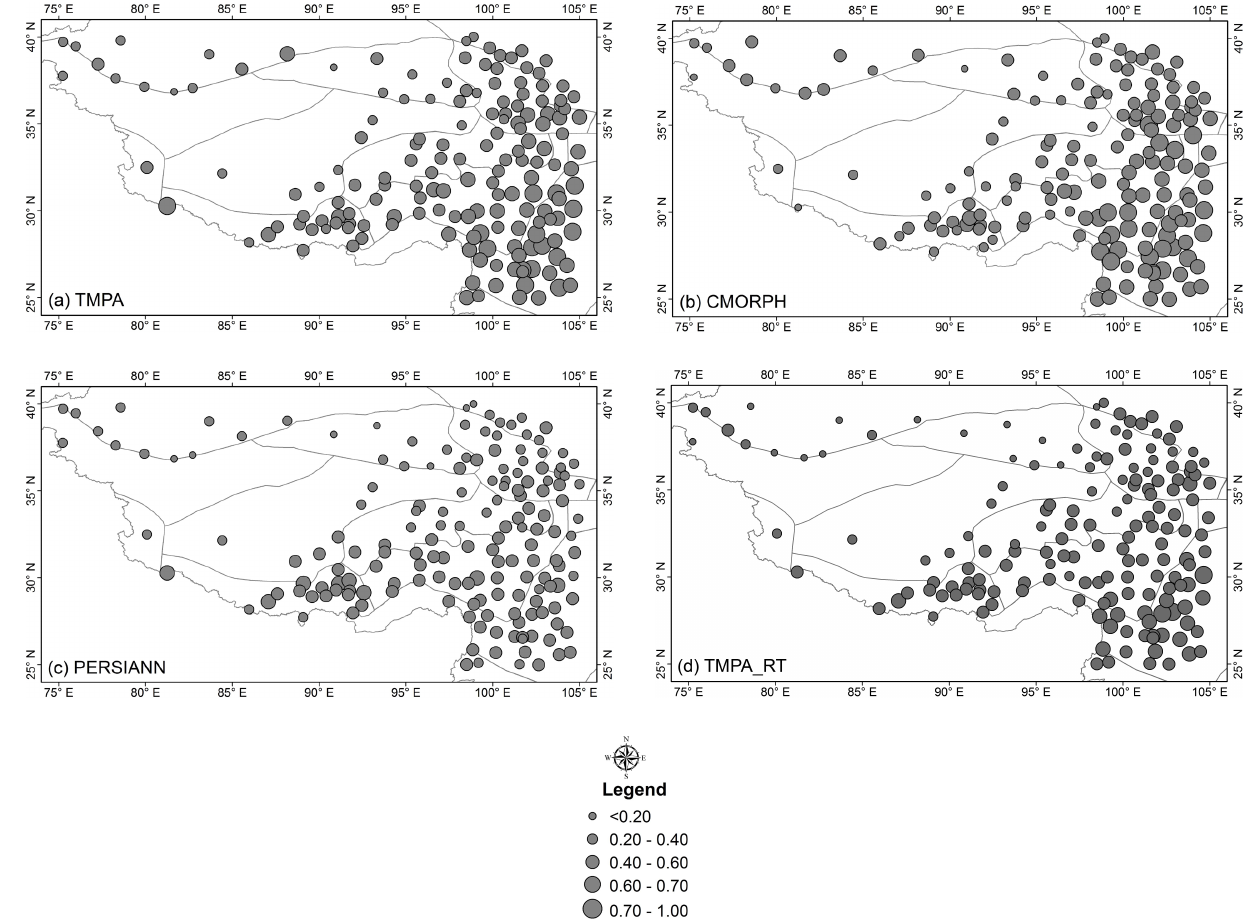
Fig. 5. The spatial pattern of correlations between gauge-based daily precipitation and that derived from satellite products from May to October during 2004–2009. Note that every circle depicts a gauge